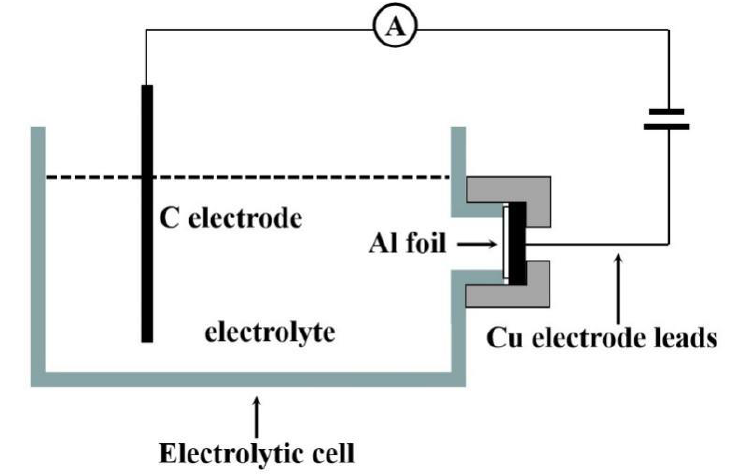
Figure 2. Schematic diagram of the AAO preparation device.